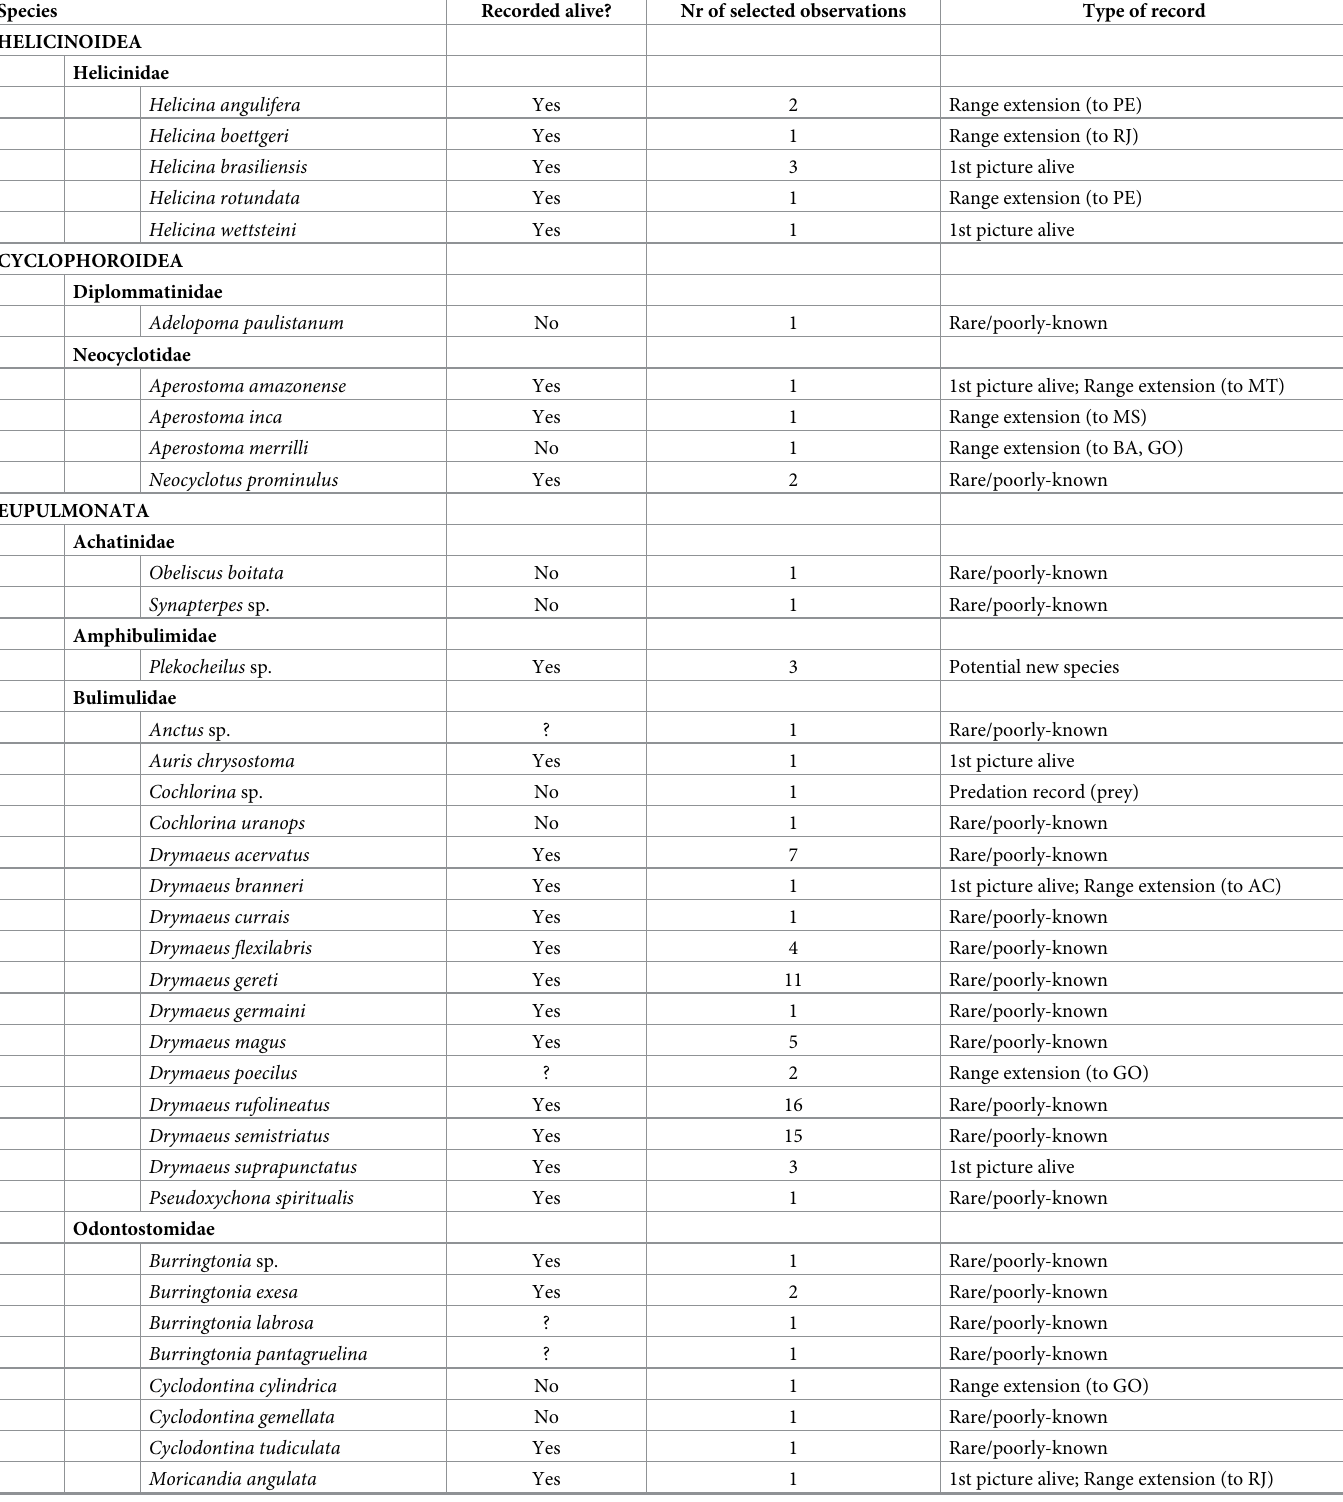
Table 1. Summary of records of interest (n = 166) for the present study compiled from iNaturalist, as of February 1st 2022.